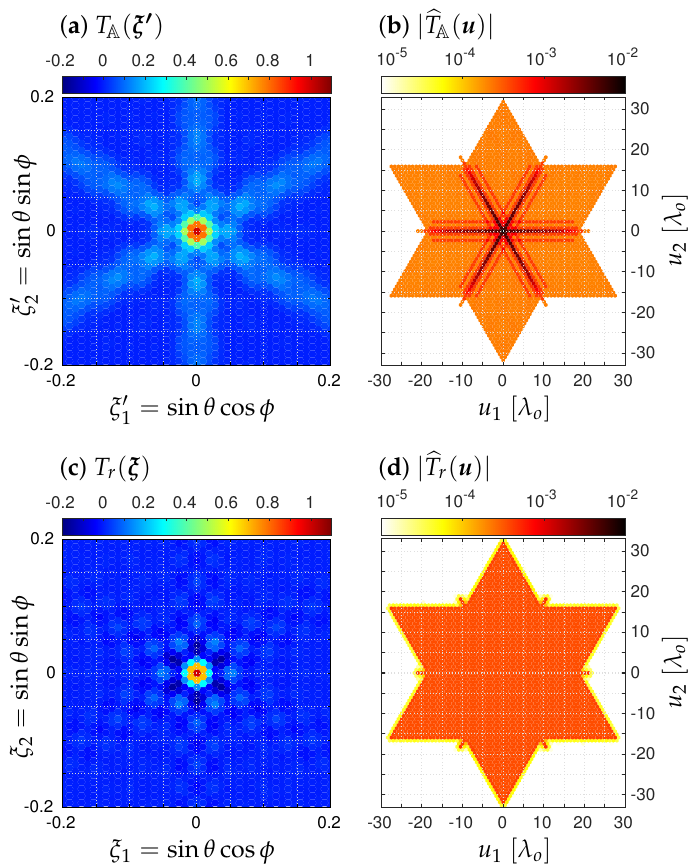
Figure 12. Close views of ( a ) the antenna temperature map T A ( ξ (cid:48) ) and ( c ) the retrieved brightness temperature map T r ( ξ ) when the observed scene T ( ξ ) is reduced to a single hot-spot in the boresight direction ξ = ( 0,0 ) (for comparison purpose with the same color scale, both maps are normalized so that their peak value is equal to 1) with the amplitude of their Fourier transforms ( b ) | (cid:98) T A ( u ) | and ( d ) | (cid:98) T r ( u ) | (also compared with the same logarithmic color scale).